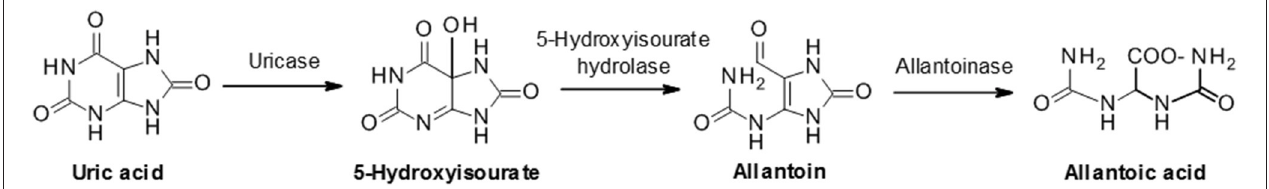
FIGURE 3 | Uric acid metabolism via uricase. In humans and some primates, uric acid is the final product of the purine catabolism pathway. However, most animals further degrade uric acid to allantoic acid via the sequential actions of uricase, 5-hydroxyisourate hydrolase and